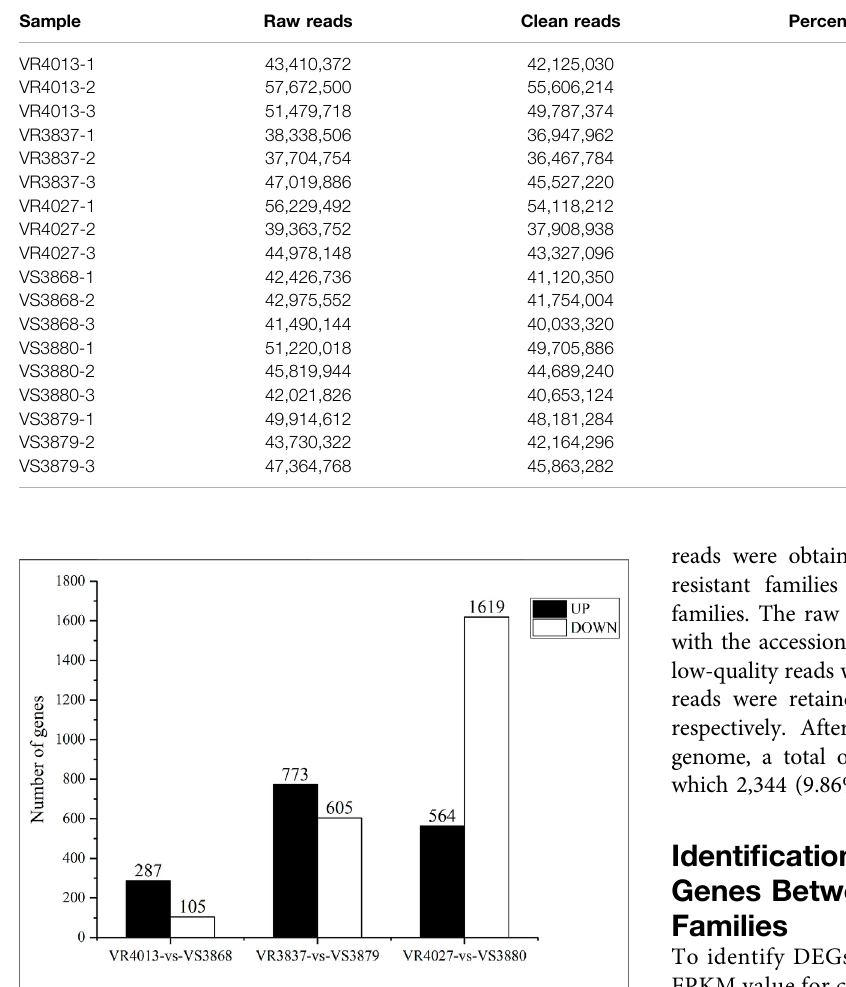
FIGURE 2 | The amount of differentially expressed genes (DEGs) between resistant and susceptible families. UP represents highly expressed genes in susceptible families. DOWN represents highly expressed genes in resistant